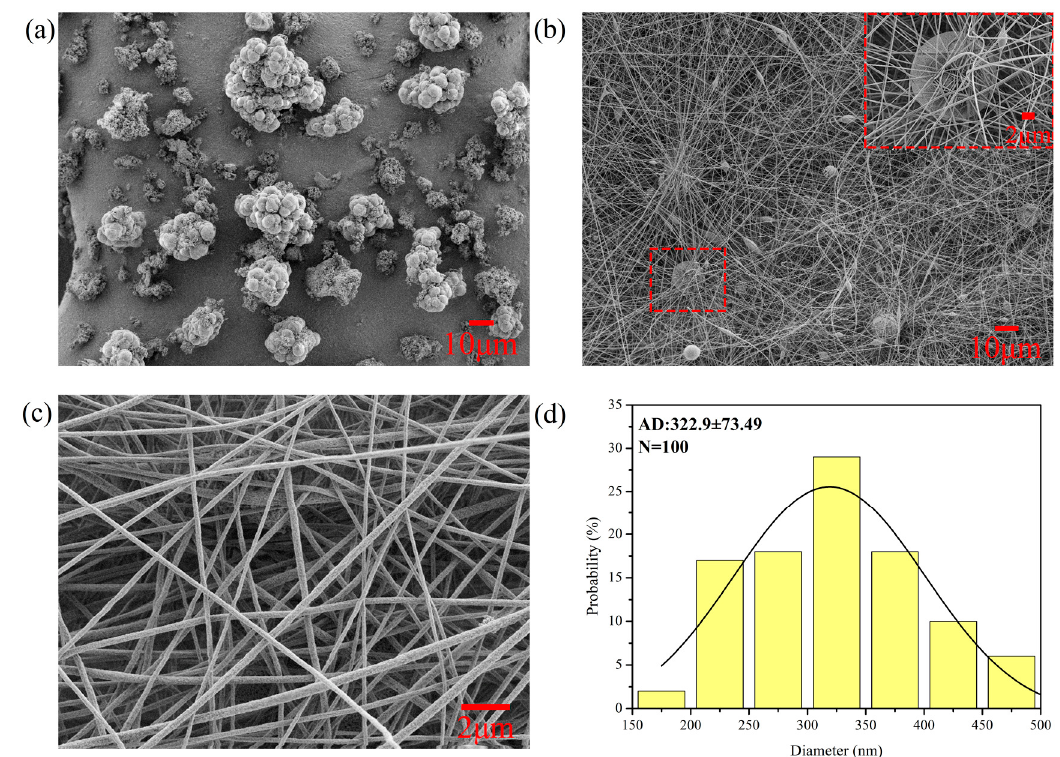
Figure 2. ( a ) SEM images of RPMs; ( b , c ) SEM images of RCMs; ( d ) Average particle size and particle size distribution images of RCMs.